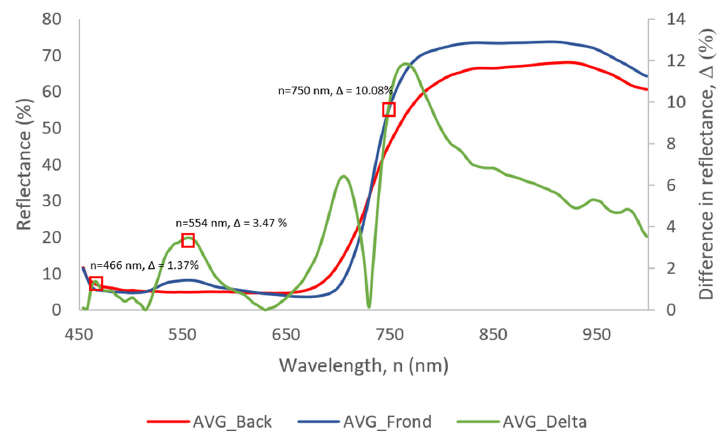
Figure 10. Graph of reflectance of the plant seedling and background against bands wavelength.